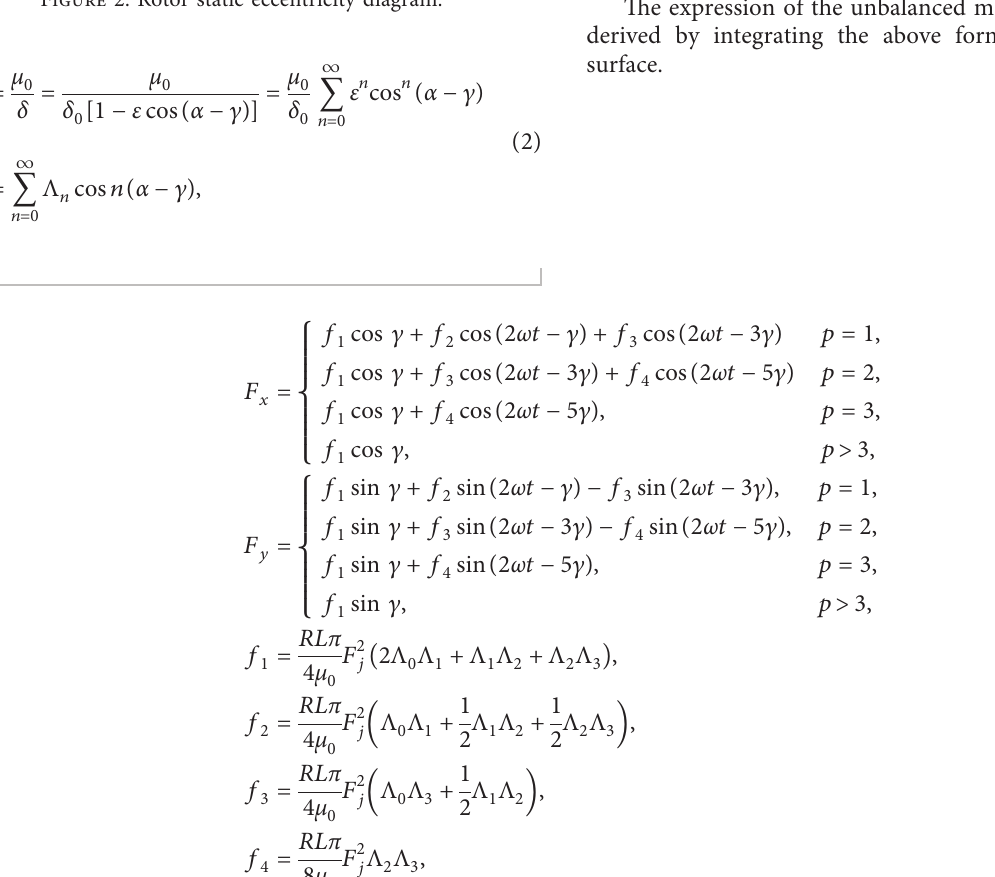
Figure 2: Rotor static eccentricity